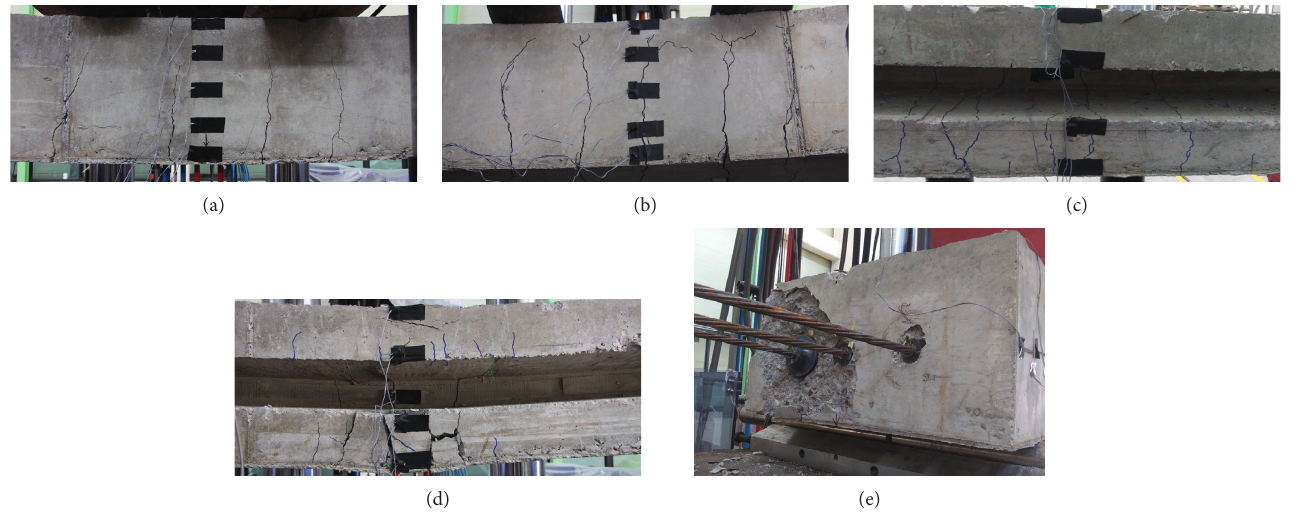
Figure 7: Failure after experiment. (a) HRP-1; (b) GRP-1; (c) HIP-1; (d) GIP-1; and (e) HRS1-3.